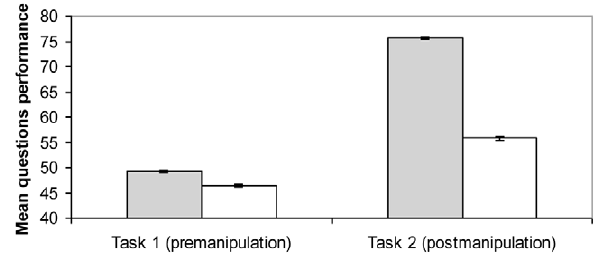
Figure 1. Mean and standard errors of the scores on performance, before and after manipulation by group (Study 1).